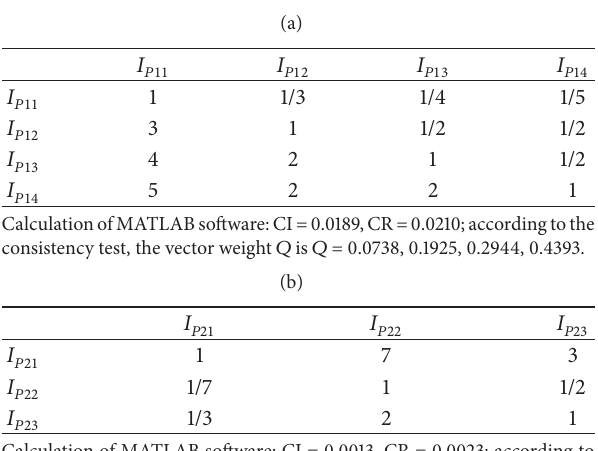
Table 8: Enterprise index judgment matrix of tertiary indicators relative to secondary indicators.